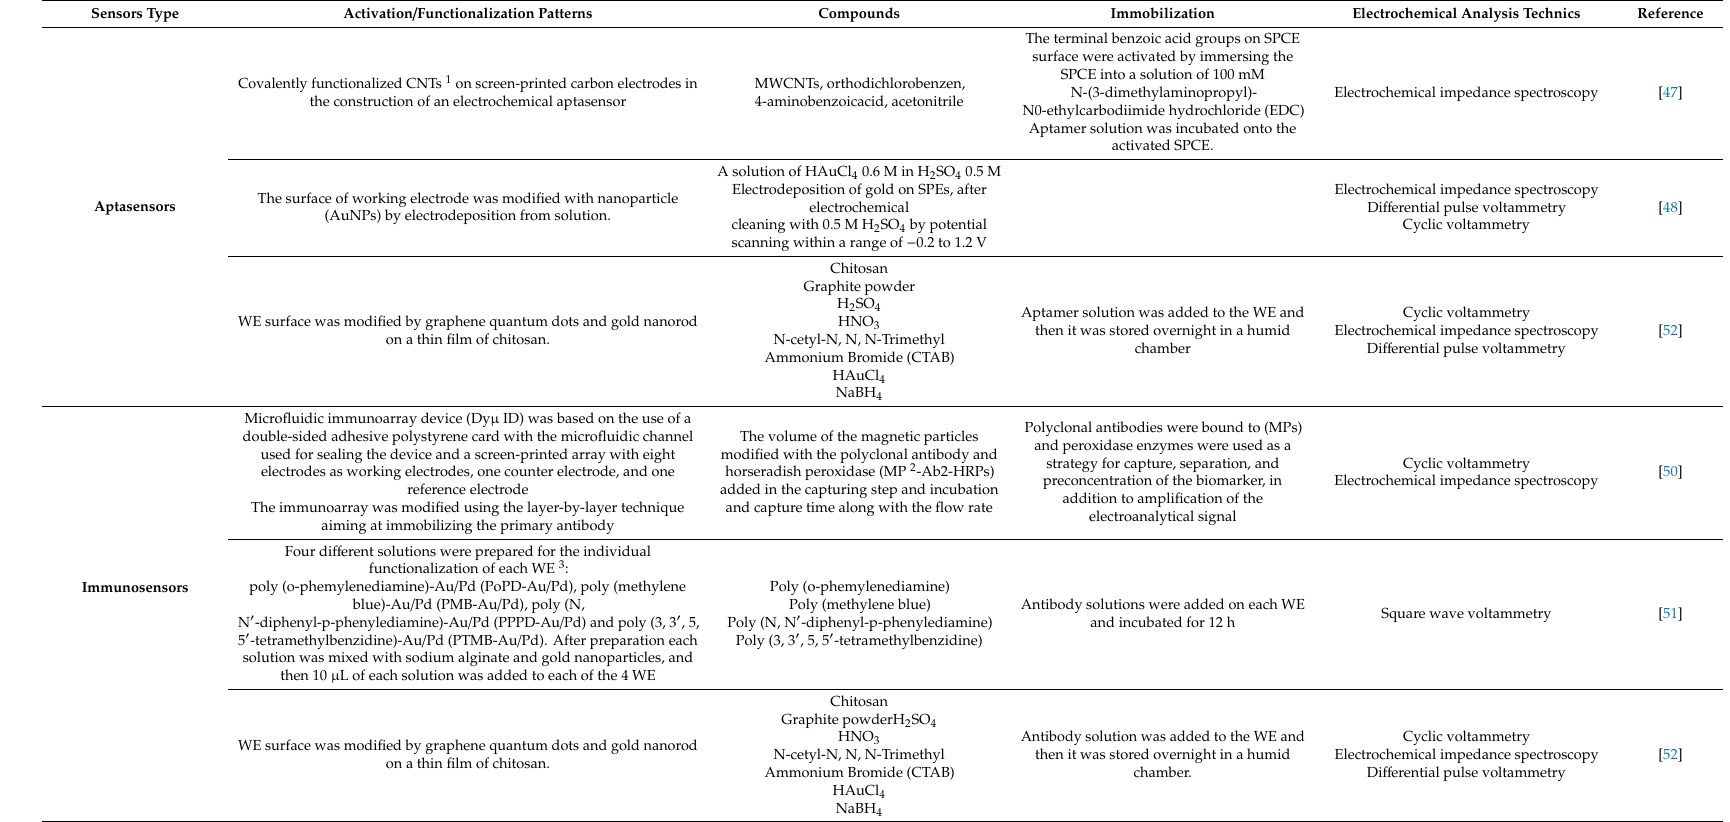
Table 3. Functionalization of various SPEs used to detect cancer related